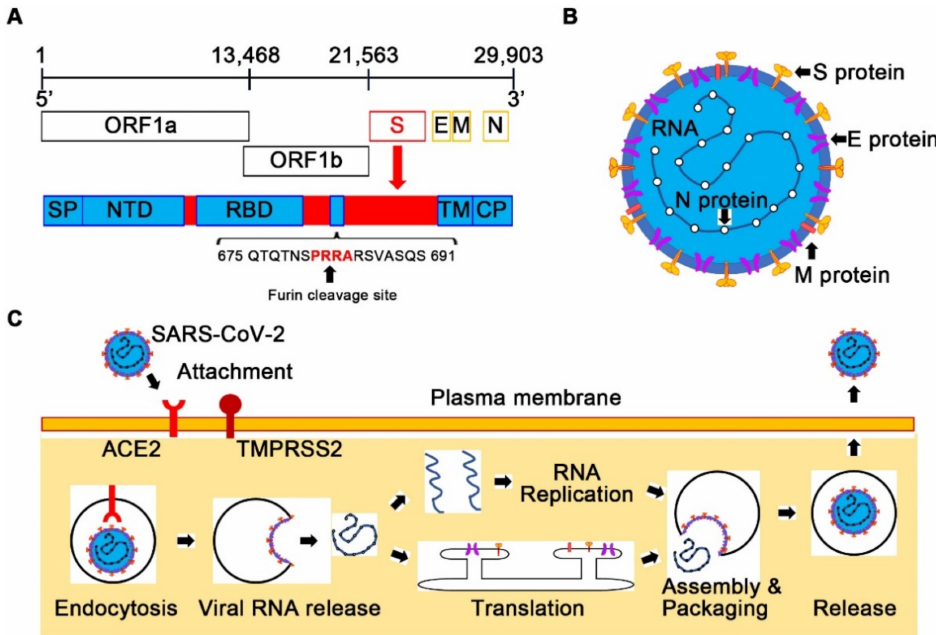
Figure 1. Genome composition, structure, and life-cycle of SARS-CoV-2. ( A ) Genome composition of SARS-CoV-2. The genome of SARS-CoV-2 is a positive-sense single-stranded RNA. Nonstructural proteins involved in genome transcription and replication are encoded in the open reading frame 1a (ORF1a) and ORF1b. The four ORFs encode the main structural proteins: the spike (S), envelope (E), membrane (M), and nucleocapsid (N) proteins. The S protein has the insertion of four amino acid residues (PRRA) that generate a polybasic cleavage site (RRAR). CP, cytoplasmic domain; NTD, N-terminal domain; RBD, receptor-binding domain; SP, signal peptide; TM, transmembrane domain. ( B ) Structure of SARS-CoV-2. SARS-CoV-2 virion consists of the envelope with three structural proteins, such as the S, E, M proteins, and the genomic RNA with the N proteins. ( C ) Life-cycle of SARS-CoV-2. SARS-CoV-2 enters host cells via its host cellular receptor, angiotensin-converting enzyme 2 (ACE2). The transmembrane protease serine 2 (TMPRSS2) cleaves and primes the receptor- bound S protein of SARS-CoV-2 for membrane fusion, which results in the release of the viral RNA genome into the cytoplasm. Translated viral structural proteins and replicated genomic RNA are assembled into the newly formed viral particles. Progeny viruses are released from the host cell by